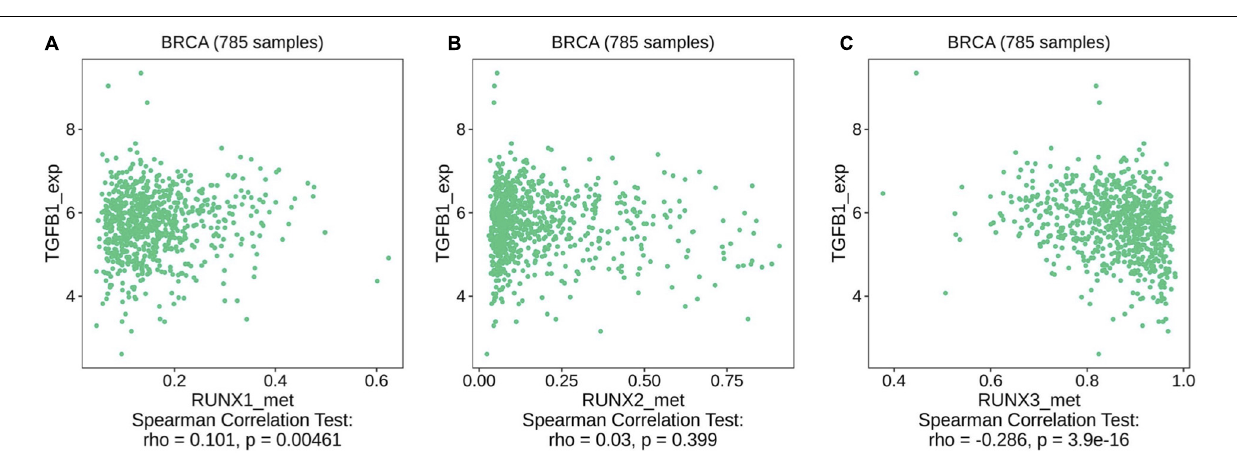
FIGURE 13 | Correlation between RUNX methylation level and TGF- β 1 expression in breast cancer. The correlations between changes in the methylation levels of (A) RUNX1, (B) RUNX2, and (C) RUNX3 with the expression of TGF- β 1 in breast cancer were